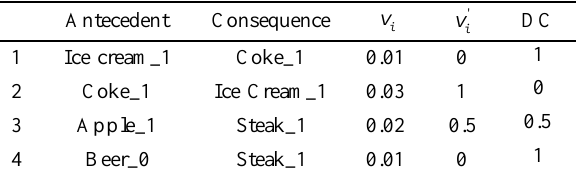
Table 6. DC of the association rules